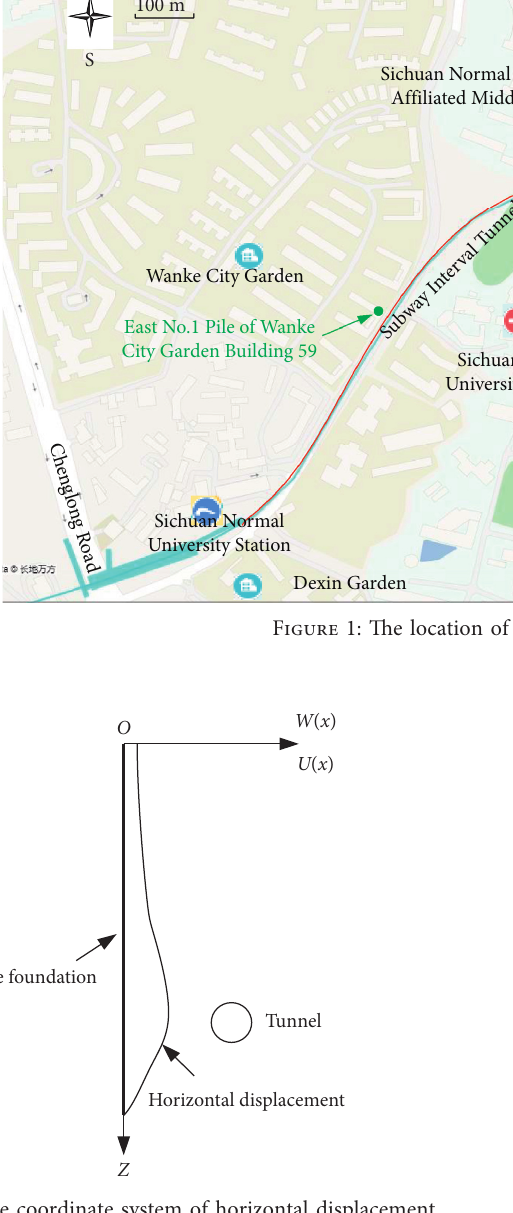
Figure 2: The coordinate system of horizontal displacement.